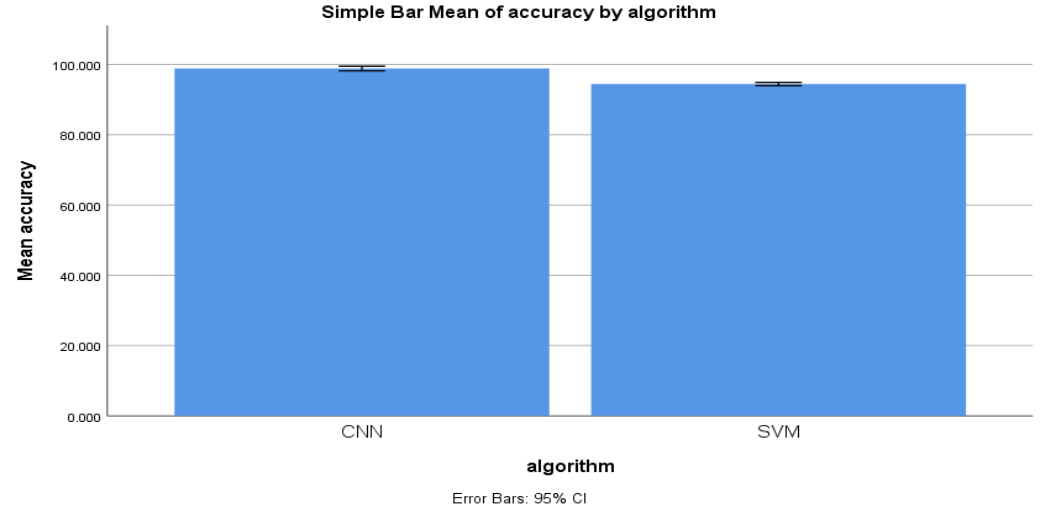
Figure 10. Simple mean accuracy for CNN and SVM algorithms.